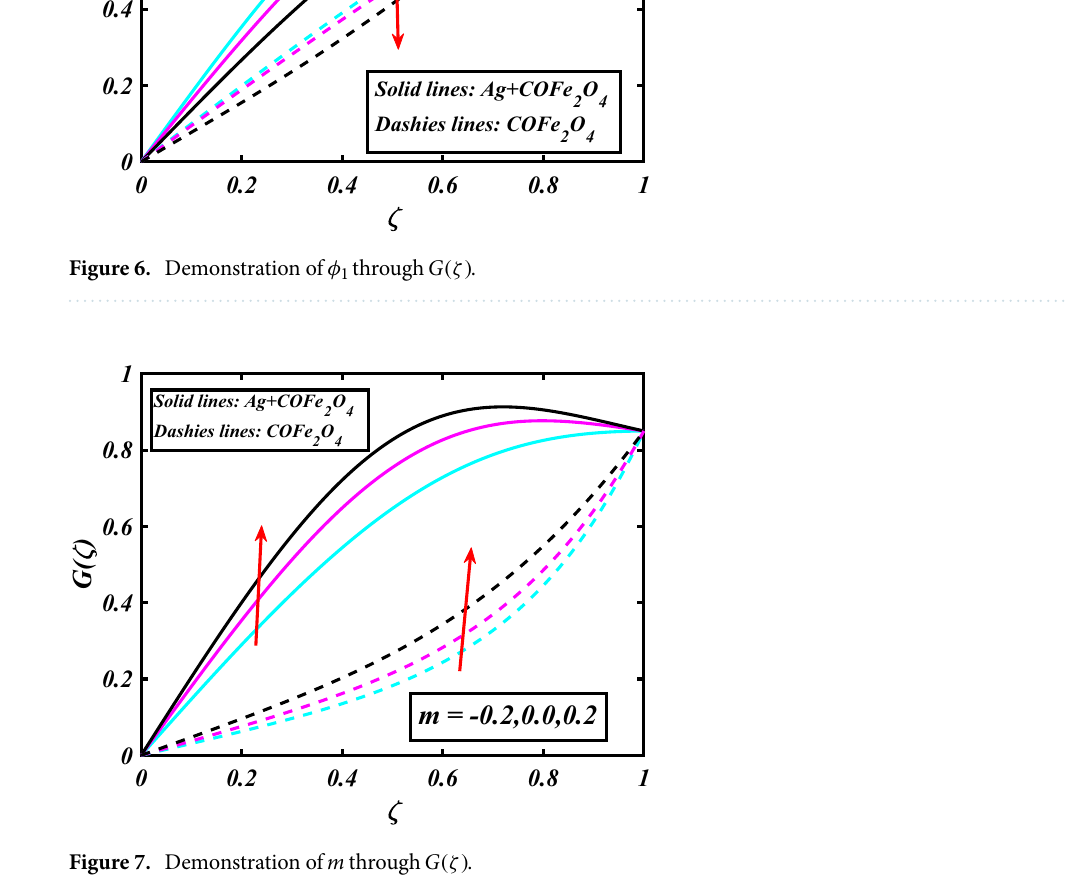
Figure 7. Demonstration of m through G (ζ)